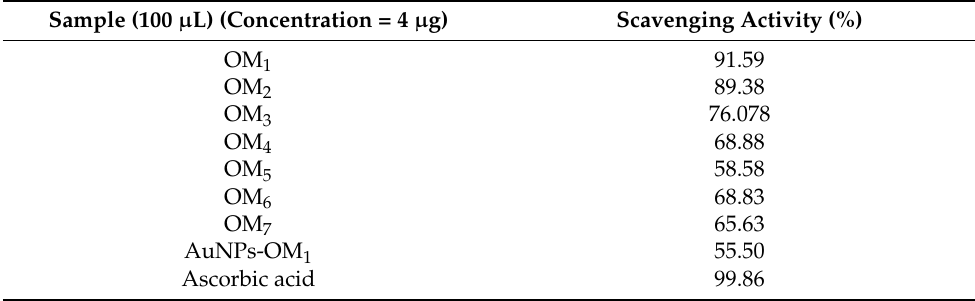
Table 4. Scavenging activity (%) of the purified compounds and AuNPs-OM 1